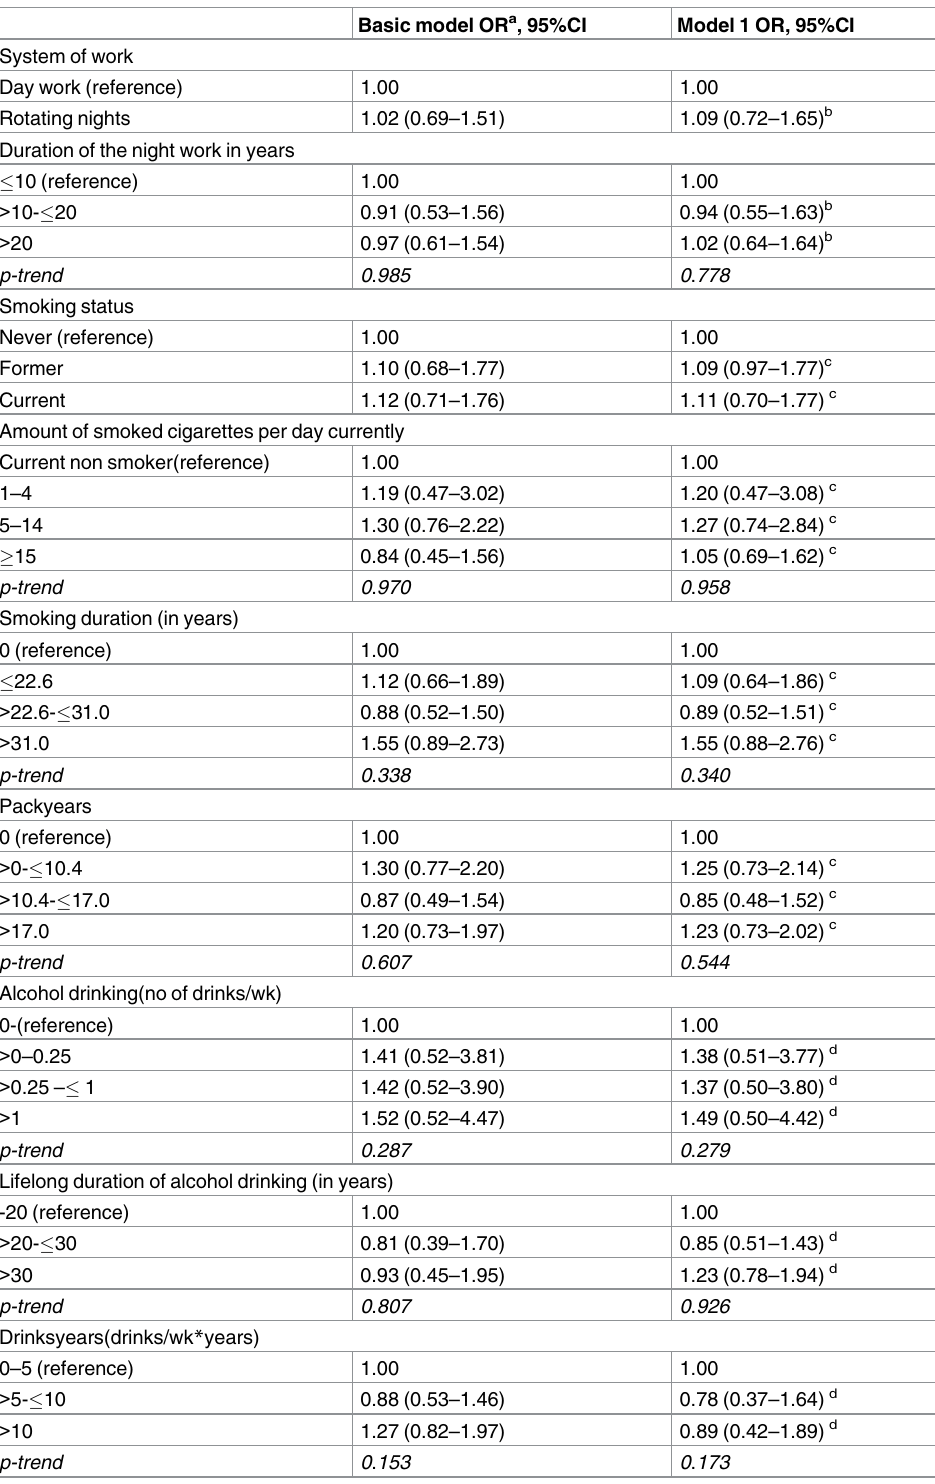
Table 3. The association between methylation of BRCA2 gene and lifestyle factors among nurses and midwives in the cross-sectional